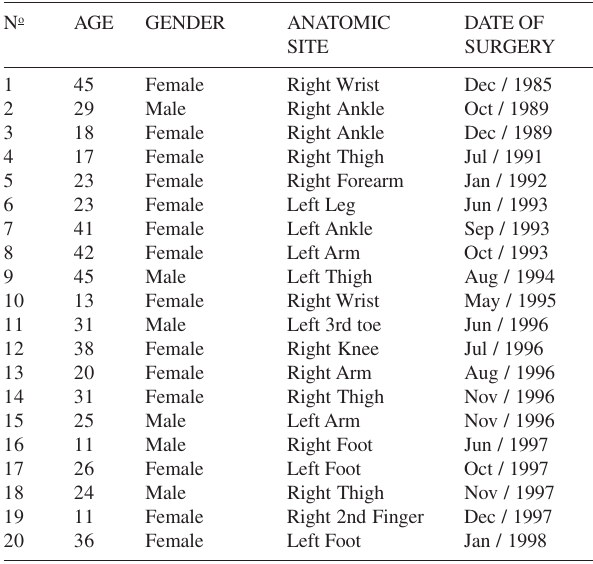
tion. A histologic grading system with prognostic signifi- cance is proposed, dividing the tumors among low and high